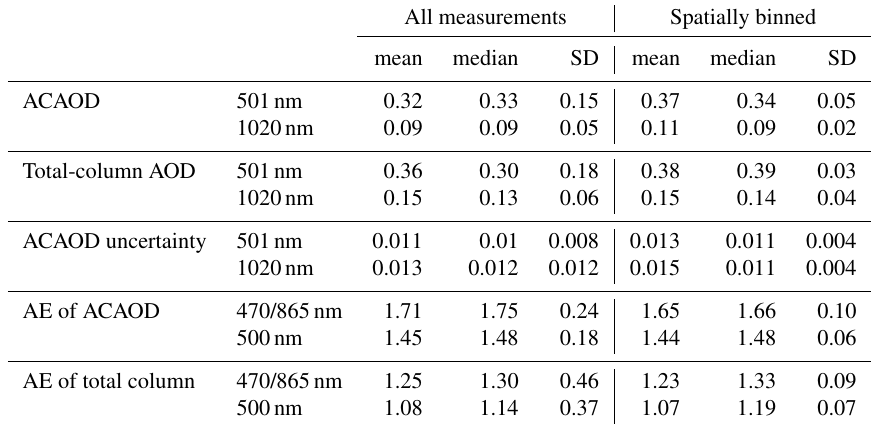
Table 1. Summary of measured aerosol optical properties during September 2016 as part of ORACLES.